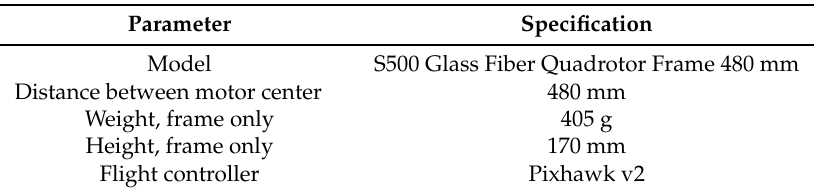
Figure 1. Unmanned aerial vehicles (UAVs) used to test methods. Table 1. Quadrotor used for navigation test.